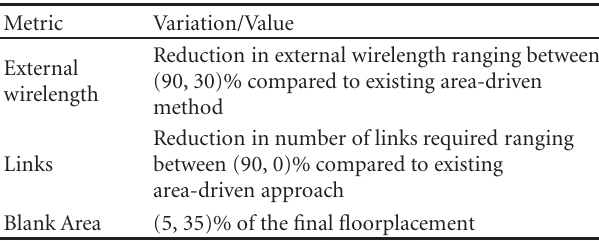
Table 2: Quality metrics and the summary of the variation in these metrics compared with existing work